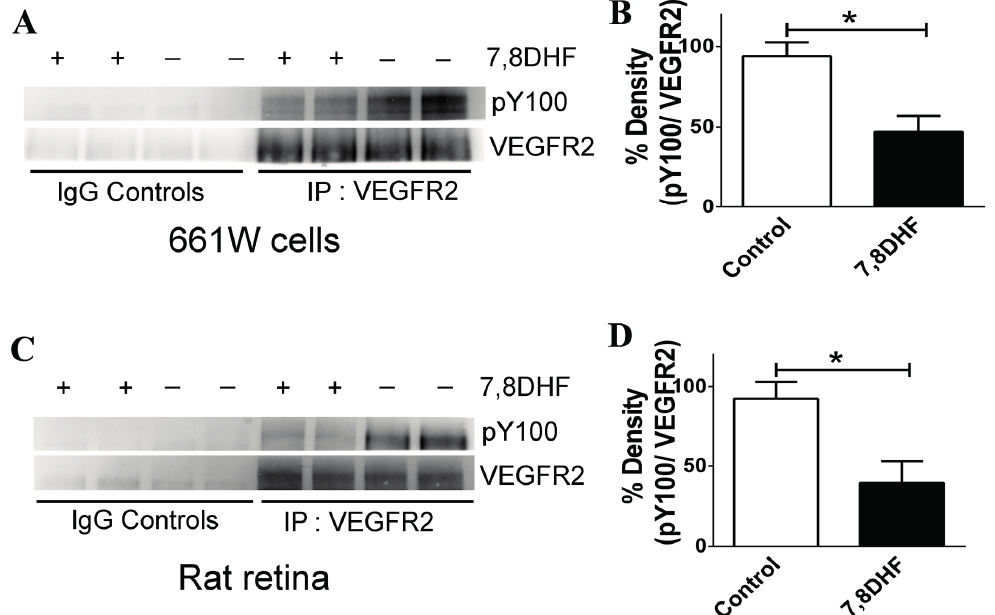
Figure 6. 7,8-DHF exerts an inhibitory effect on the VEGFR2. ( A ) Immunoprecipitation of VEGFR2 was carried out from 661W cell lysates followed by probing with the VEGFR2 and PY100 antibodies; ( B ) Quantification illustrated a decline in VEGFR2 phosphorylation upon treatment with 7,8-DHF ( * p < 0.04); ( C ) Immunoprecipitation of VEGFR2 from retinal lysates followed by probing with the VEGFR2 and PY100 antibodies; ( D ) Quantification illustrated a decline in VEGFR2 phosphorylation from rats treated with 7,8-DHF ( * p <